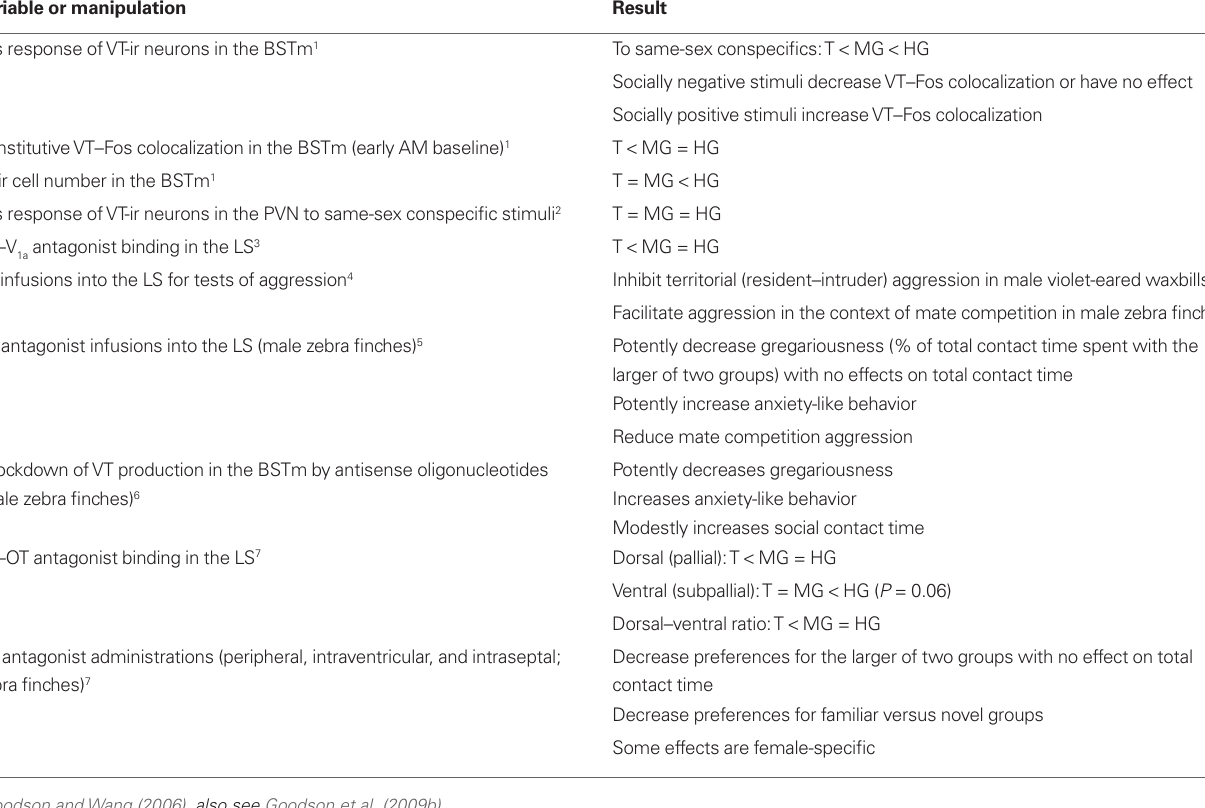
Table 2 | A summary of main findings from studies of nonapeptide systems in territorial (T), moderately gregarious (MG), and highly gregarious (HG) species of estrildid